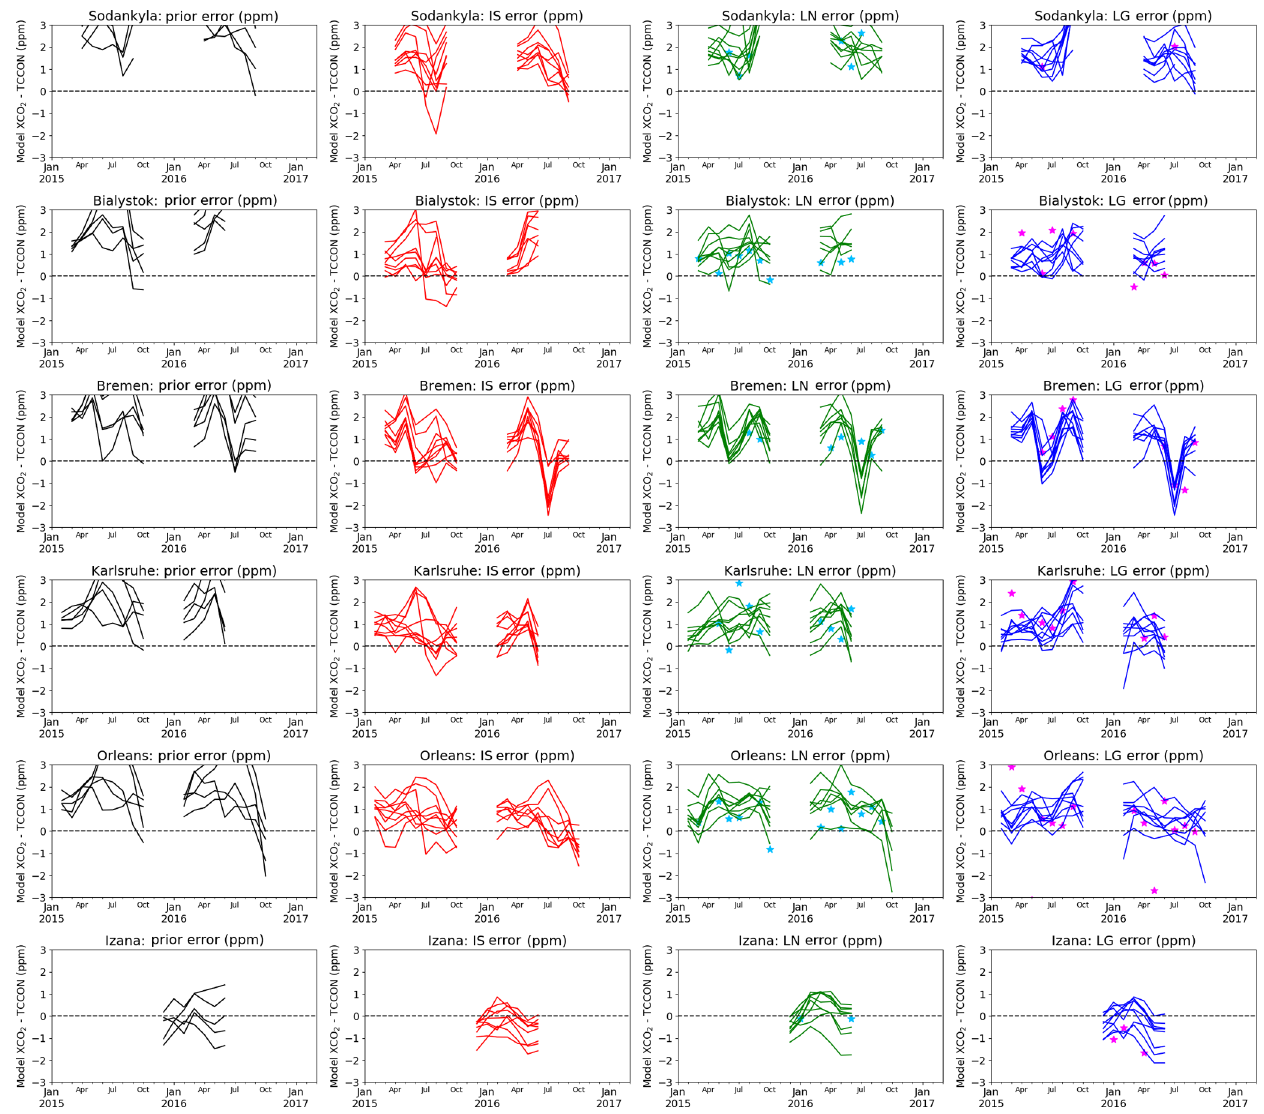
Figure C3. As in Fig. C2, but for European TCCON